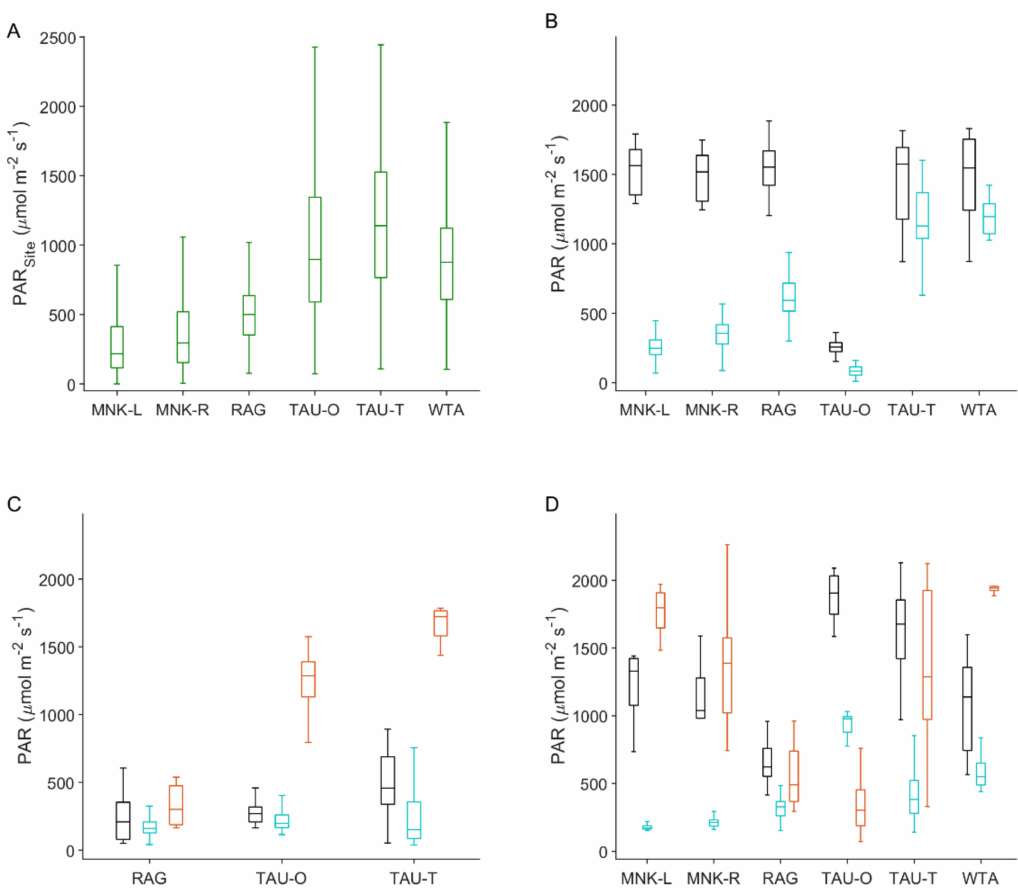
Figure 2. Measured photosynthetically active radiation (PAR) at each site; ( A ) PAR Site , daily maximum value over a 9-month period (March–November 2017), and during primary production measurements in ( B ) November 2017 (T1), ( C ) June 2018 (T2) and ( D ) November 2018 (T3). Black and blue bars indicate PAR i (incident, water surface) and PAR Sed (sediment surface), respectively, during submerged sampling periods. Red indicates PAR i during emerged sampling. Boxes represent the 25th and 75th percentiles, whiskers the 5th and 95th percentiles and a solid line within each box denotes the median. No consistent relationship was found between water column turbidity and sediment characteristics (Table 2). On average, mud content was relatively low ( < 4%) at MNK-R, TAU-T and WTA on all sampling dates. The highest mud content was recorded at RAG (maximum of 28%) with both MNK-L and TAU-O predominately > 10%. Organic content was also relatively low at all sites ( < 5%) while median grain size (MGS) varied between sites (an average of 123 µ m in RAG to 248 µ m in WTA). Microalgal biomass (sediment chl a content) was highly variable with no clear relationship between sites or sampling dates. Univariate measures of macrofaunal community di ff ered between sites (Table 2; see Tables A3 and A4 for community composition data). Most notable was the high − 1 abundance of A. stutchburyi ( > 50 core ) at MNK-L, RAG and WTA which contributed to higher total macrofaunal